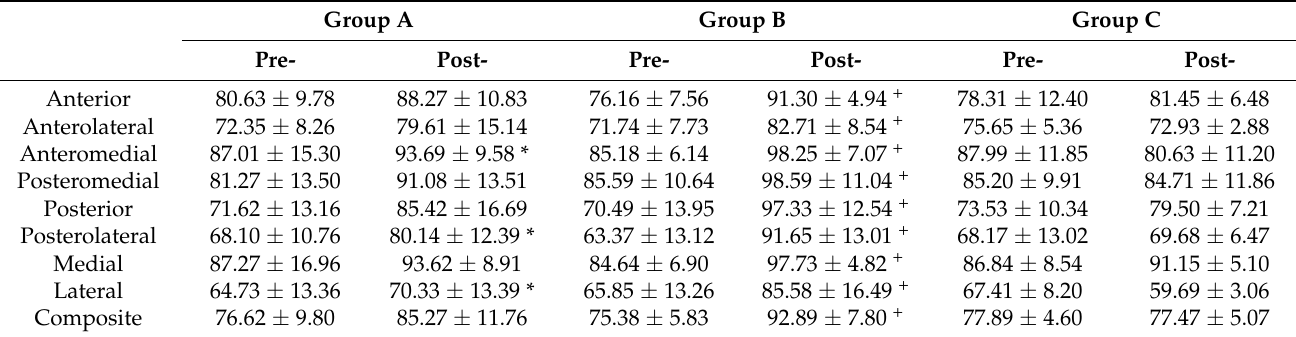
Table 4. Results of star excursion balance test in three group.